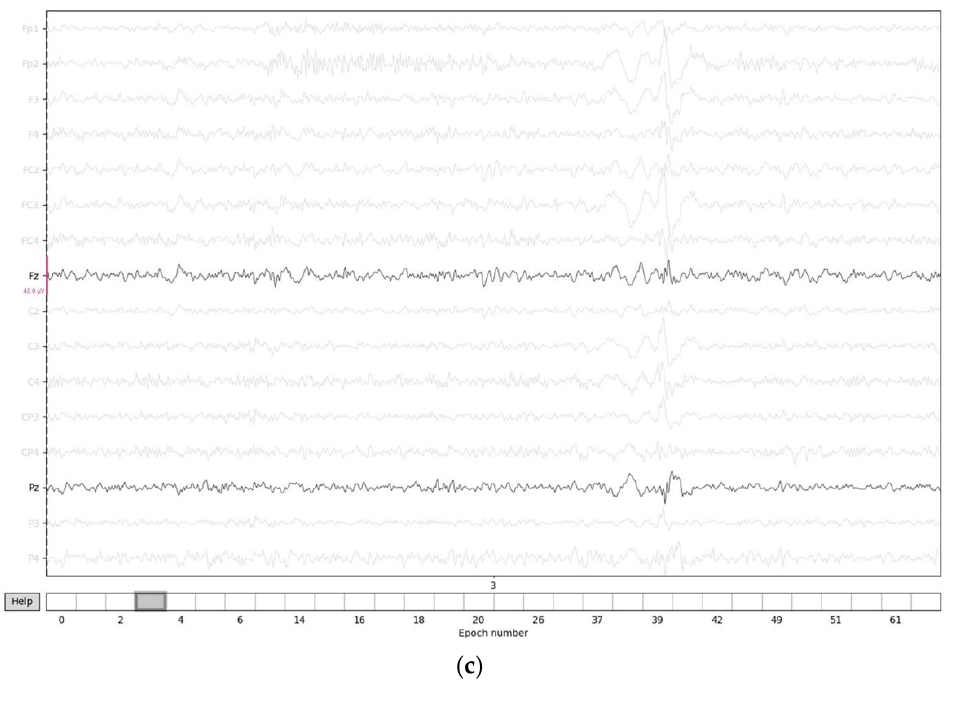
Figure 2. EEG signals: ( a ) raw EEG signals; ( b ) filtered EEG signals; ( c ) artifact-free EEG signals.